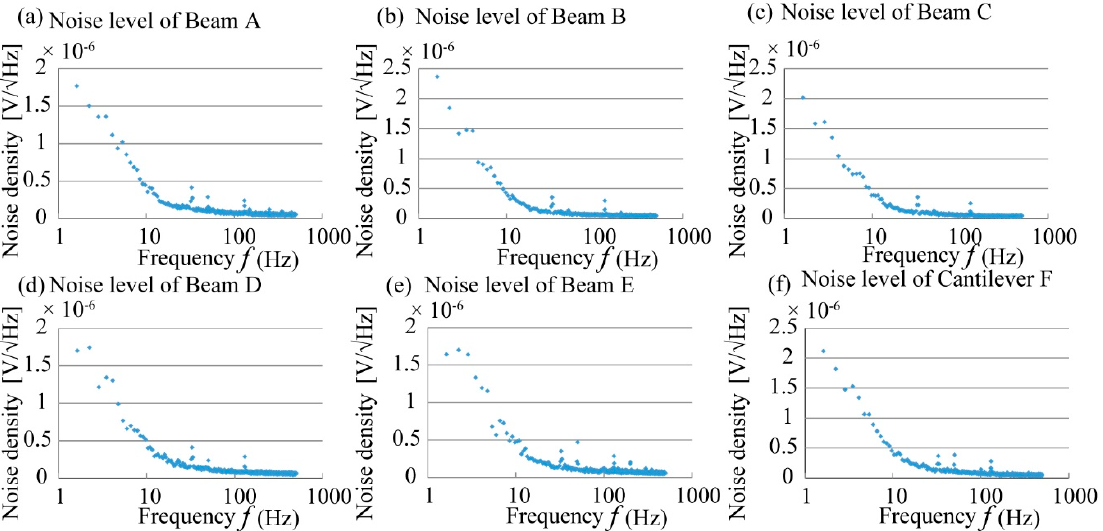
Figure 16. Noise levels of the sensing elements inside the fabricated sensor chip. ( a – f ) the measured results of the noise levels for each sensing element. Table 4. Noise levels of each element. Beam